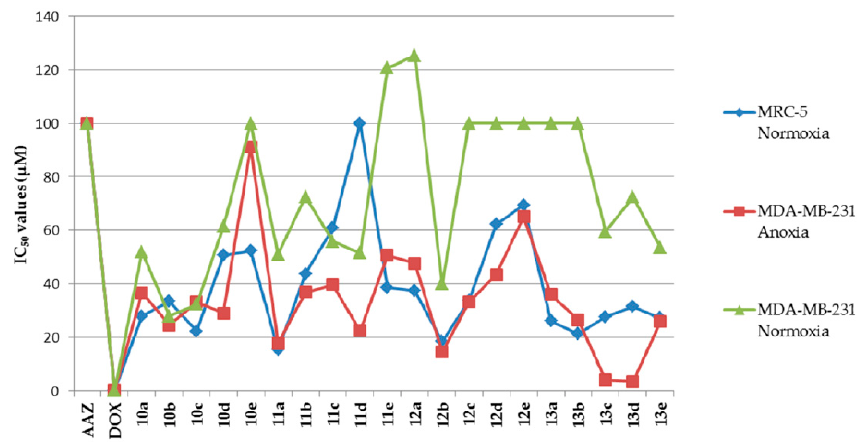
Figure 1. The line chart of the IC 50 values of tested compounds against MRC-5 and HT-29.